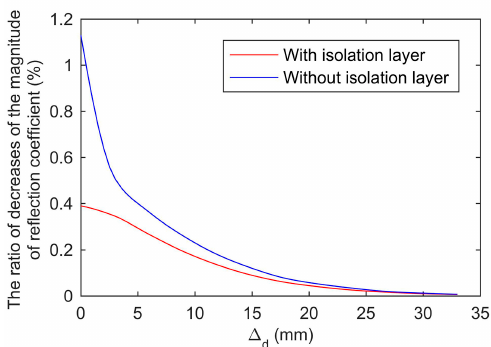
Figure 23. The ratio of decreases of the magnitude of reflection coefficient with the complex permittivity increasing by 10%.